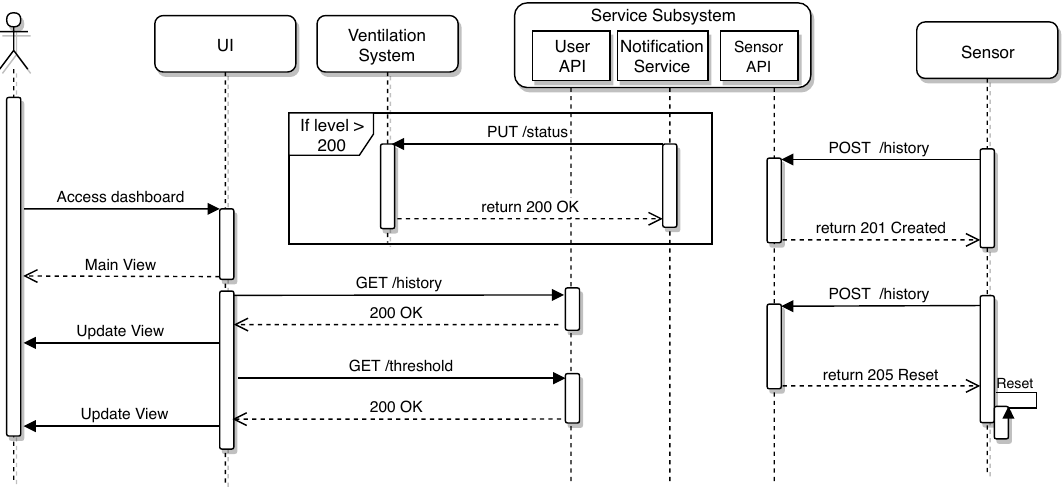
Figure 8. Sequence diagram about the sensor value collection and user